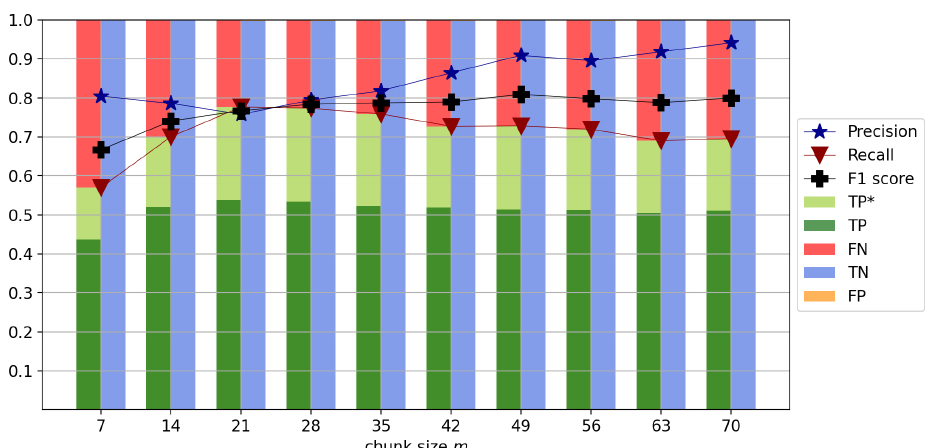
Figure 13. Classification result for testing stations for different chunk sizes m . A detailed description of the figure content and acronyms are presented in the captions of Figures 4 and